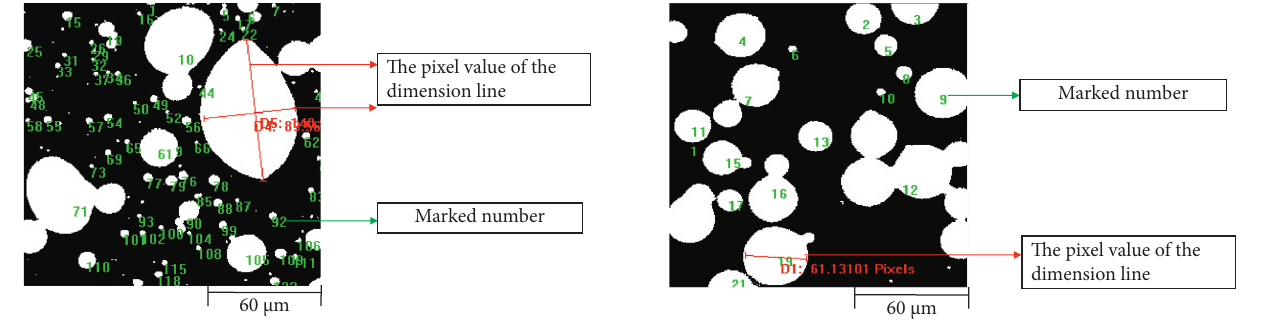
Figure 11: Fluorescence microscopic binarization image of SBS modified asphalt with 10% content of APR.